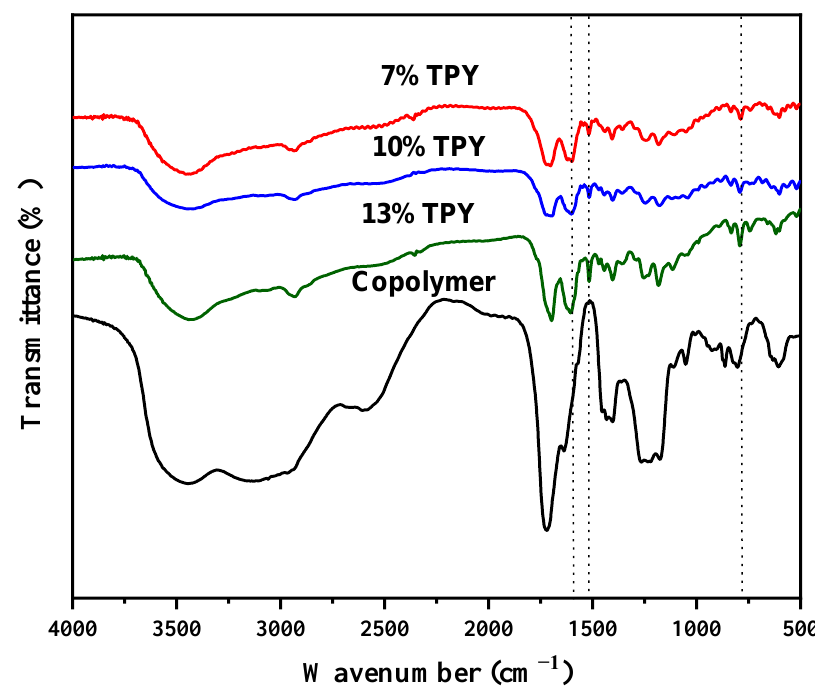
Figure 1. FTIR spectra of PAAMa , P1 , P2 , and P3 .